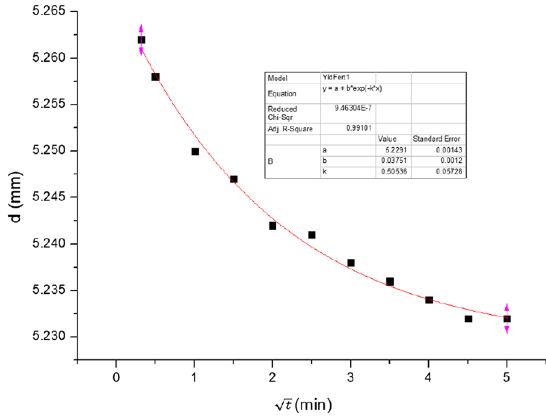
Fig. 7 Curve fitting equation of d – √